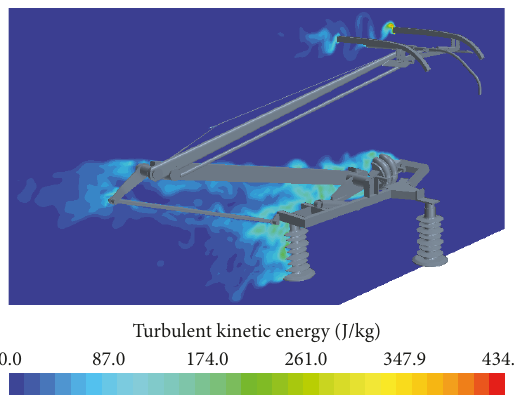
Figure 8: Eddy distributions on center cross section of